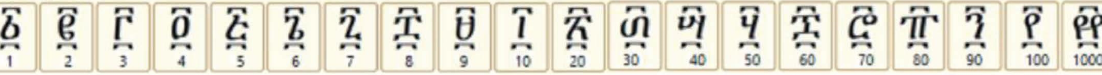
Figure 1: Geez number representations